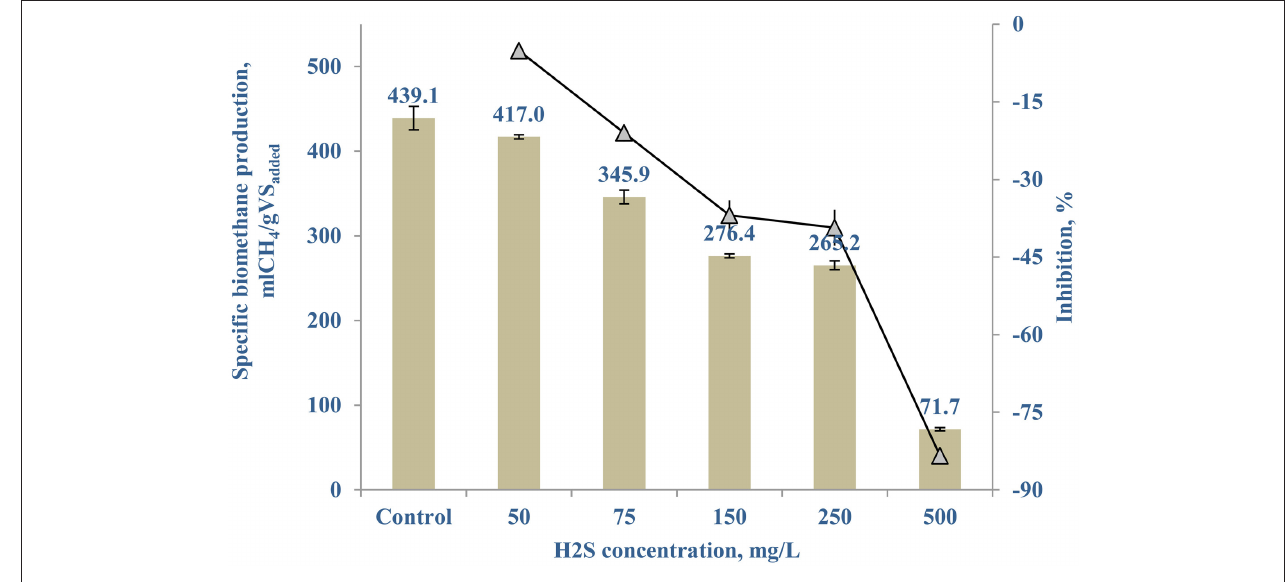
FIGURE 7 | Effect of hydrogen sulfide toxicity on AD of FW-B.